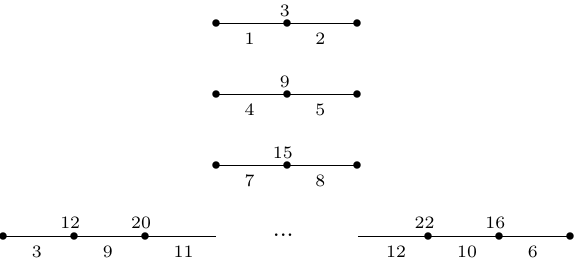
Figure 4. Vertices in 3 P 3